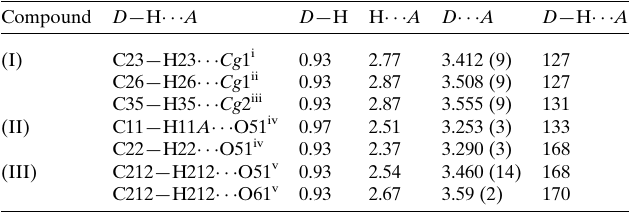
Table 1 Hydrogen bonds and short intermolecular contacts (A˚ , (cid:4) ). Cg 1 and Cg 2 represent the centroids of the rings (C31–C36) and (C21–C26), respectively. Compound D —H (cid:2)(cid:2)(cid:2)